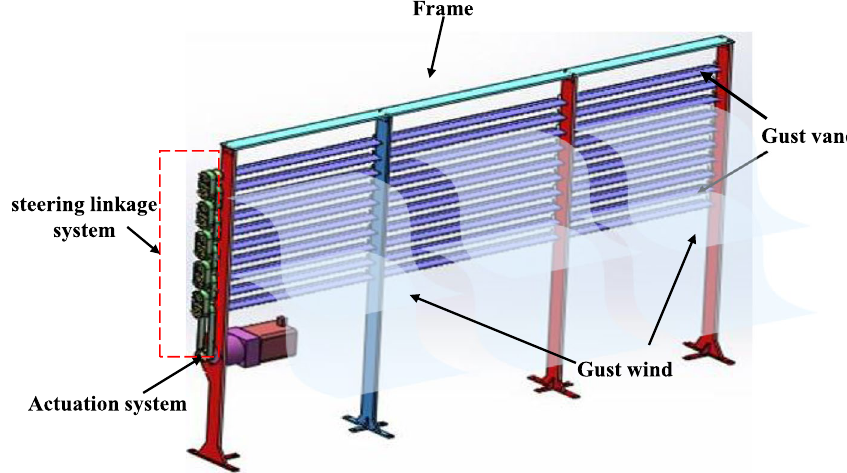
Fig. 3 Design sketch of gust wind